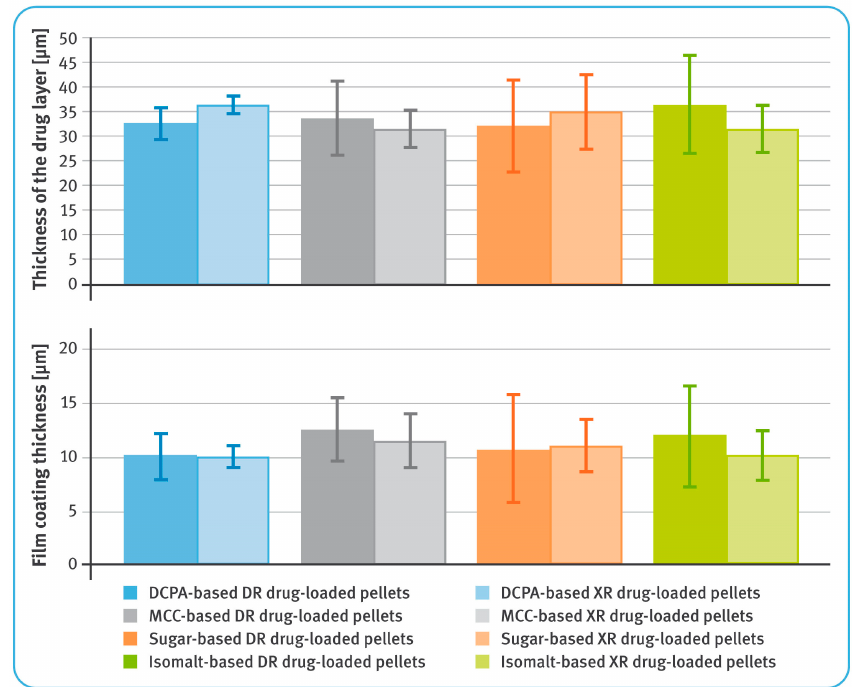
Figure 3. Thicknesses of layers containing diclofenac sodium (upper) and film coatings (lower) (mean of n = 6, SD are indicated by the error bars). In general, the average thicknesses of the coating layers (both containing the drug substance as well as dissolution-controlling layers) were very similar for all pellets, re- gardless of the chemical nature of their cores (Figure 2). For both DR and XR pellets, thick- nesses of the layers with diclofenac sodium were in the range of 31–37 µm. For DR pellets, the average thicknesses of the gastro-resistant layers were between 10 and 13 µm, and for XR pellets, the thicknesses of dissolution-controlling layers were around 10–12 µm. It was observed that in the case of less spherical and less convex pellets, the layers were unevenly distributed (Figure 2). The average content of diclofenac sodium in the drug-loaded pel- lets was similar for all tested multiparticulates and amounted to around 7.2–7.6% w/w of DR pellets, and 7.9–8.2% w/w of XR pellets (Table 4). 3.2. Dissolution Testing of Diclofenac Sodium DR Pellets The release of the drug substance from capsules containing enteric-coated pellets in amounts equivalent to 25 mg of diclofenac sodium was first examined after 2 h maceration in 0.1 M hydrochloric acid and neutralization of the solution with 5 M sodium hydroxide. The results are shown in a smaller box in Figure 4, and for all pellet types, they were within the limits required for this type of preparations, i.e., not more than 10% of the la- beled content should be dissolved. The amount of diclofenac sodium dissolved was lower in the case of DCPA- and MCC-based pellets by about 1% compared to those comprising sucrose or isomalt. It should be noted that the latter two types of pellets showed a ten- dency to float and gather in the upper part of baskets. An example of similar behavior is shown in the smaller box in Figure 5.